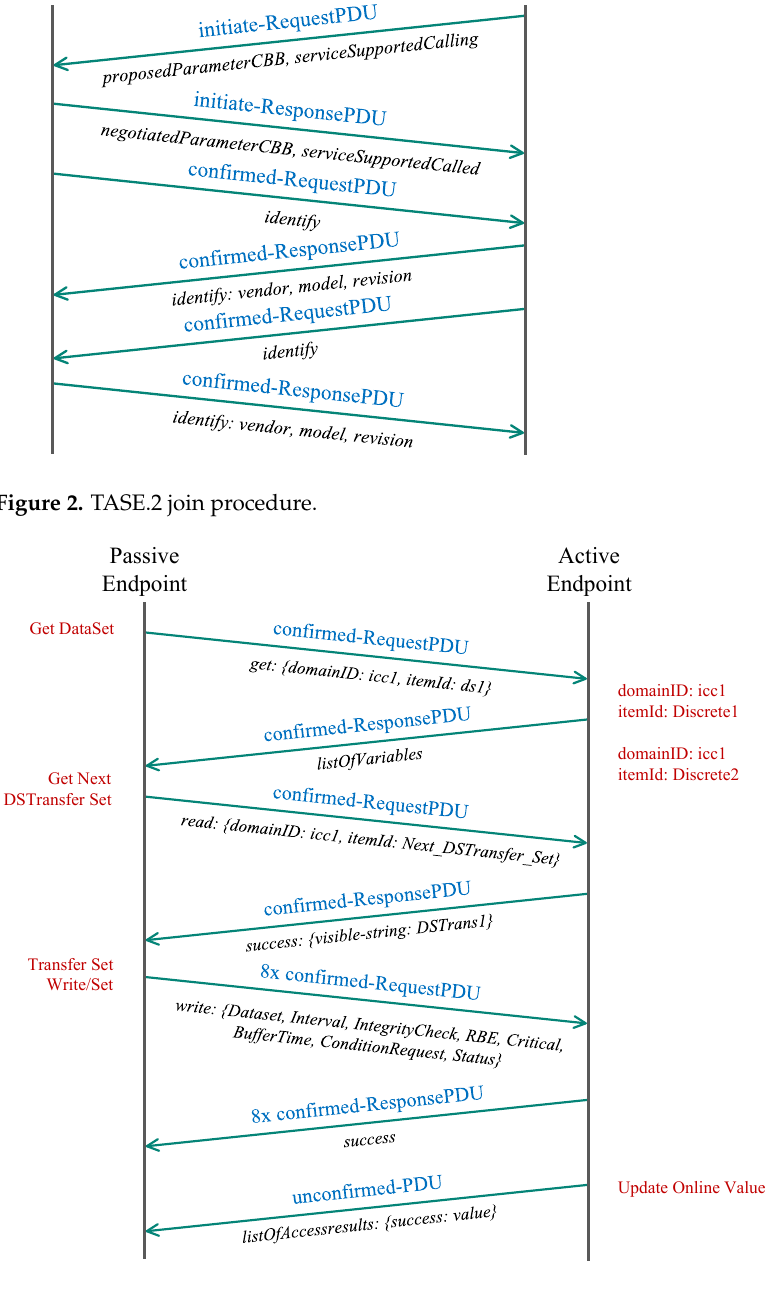
Figure 3. TASE.2 PUSH communication